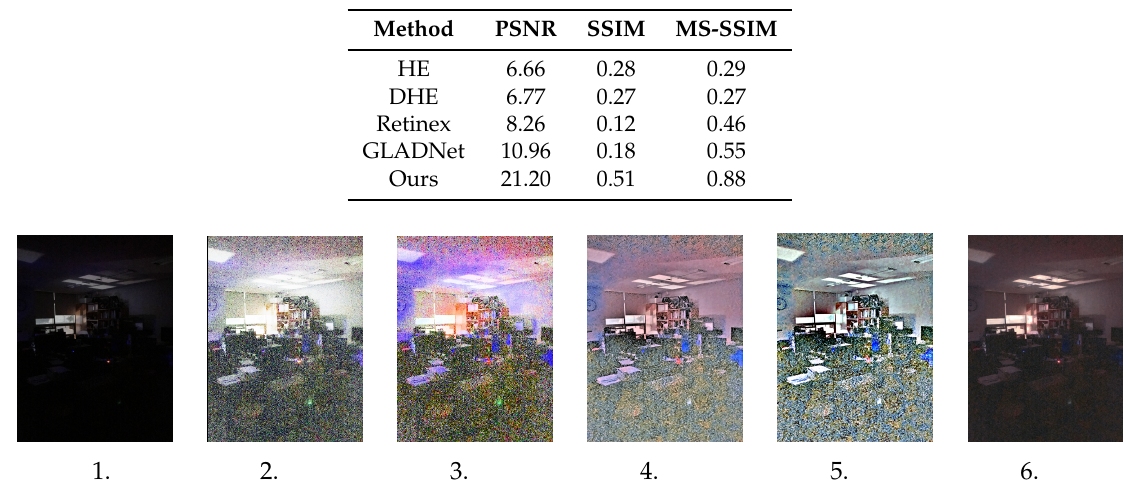
Table 1. The qualitative comparison of synthetic extreme low-light images.